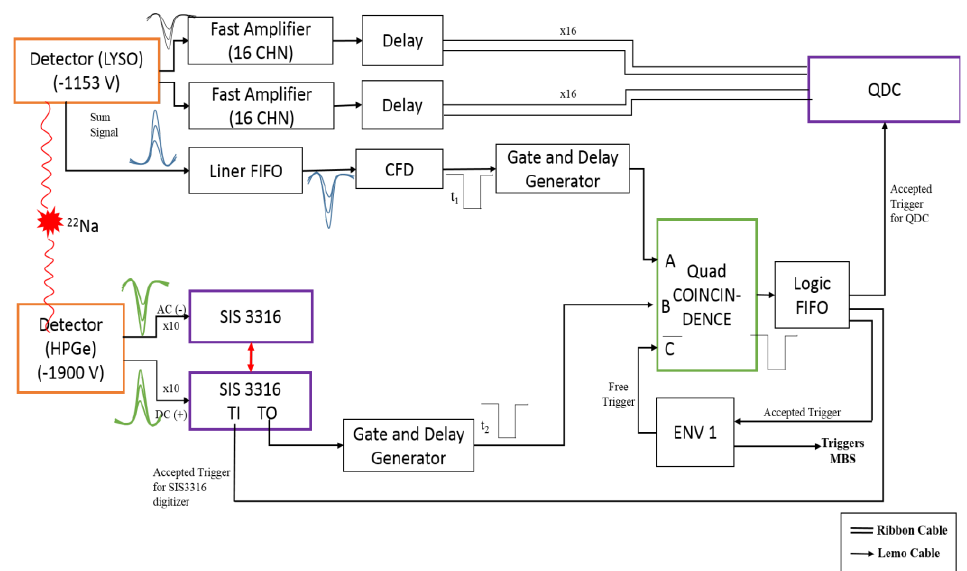
Fig. 2: Typical block diagram of electronics arrangement used for setting up the coincidence between PSD and PSPGe